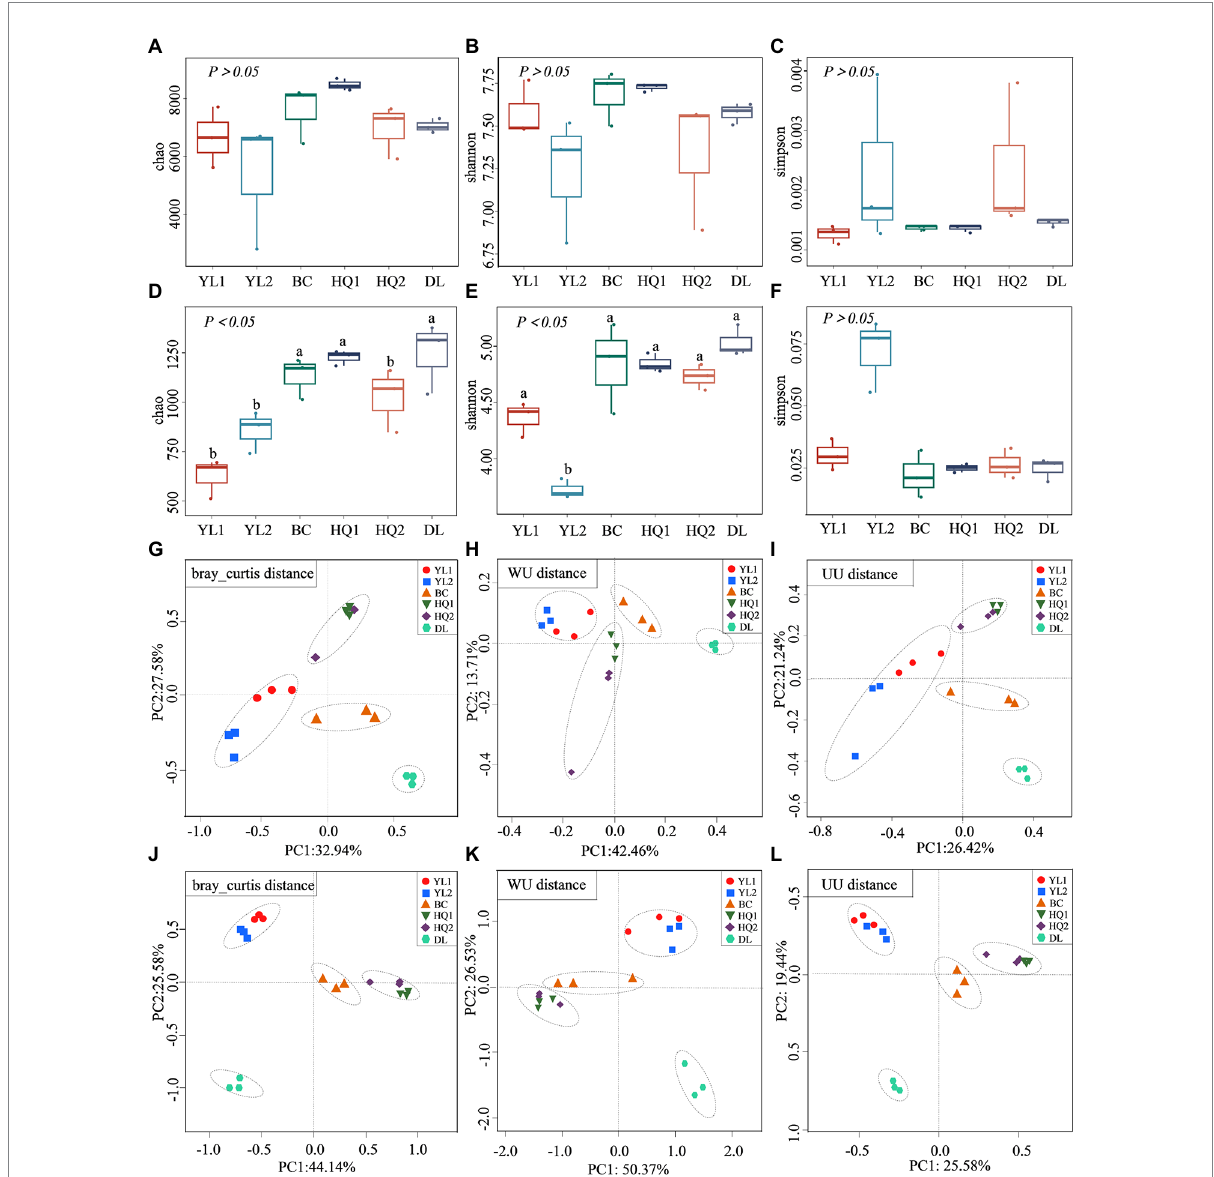
FIGURE 2 Alpha and beta diversity of microbial communities. (A–F) The alpha diversity index of Chao (A) , Shannon (B) , and Simpson (C) for the bacterial community; the alpha diversity index of Chao (D) , Shannon (E) , and Simpson (F) for the fungal community, different letters on the bars indicate significant differences ( p < 0.05). (G–L) the beta diversity of the bacterial community based on the Bray-Curtis (G) , WU (I) , and UU distances (H) ; the beta diversity of the fungal community based on the Bray-Curtis (J) , WU (K) , and UU distances (L)